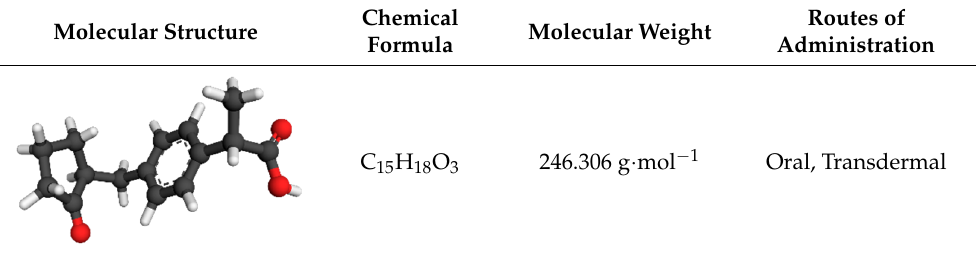
Table 1. Structure and characteristics of Loxoprofen [8,9]. Molecular Structure